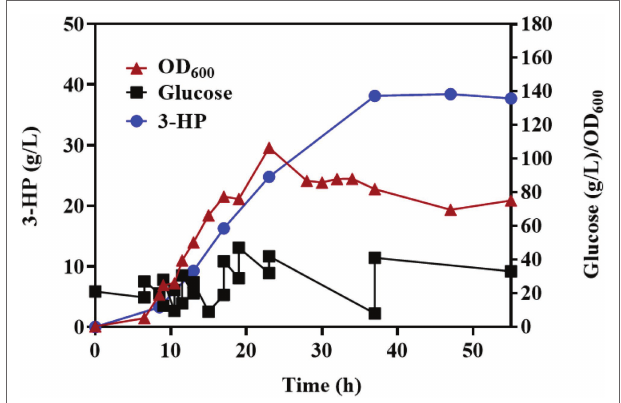
FIGURE 7 | The fed-batch process with Q-3434 in a 7.5-L bioreactor. Biomass, glucose consumption, and 3-HP accumulation were monitored in real